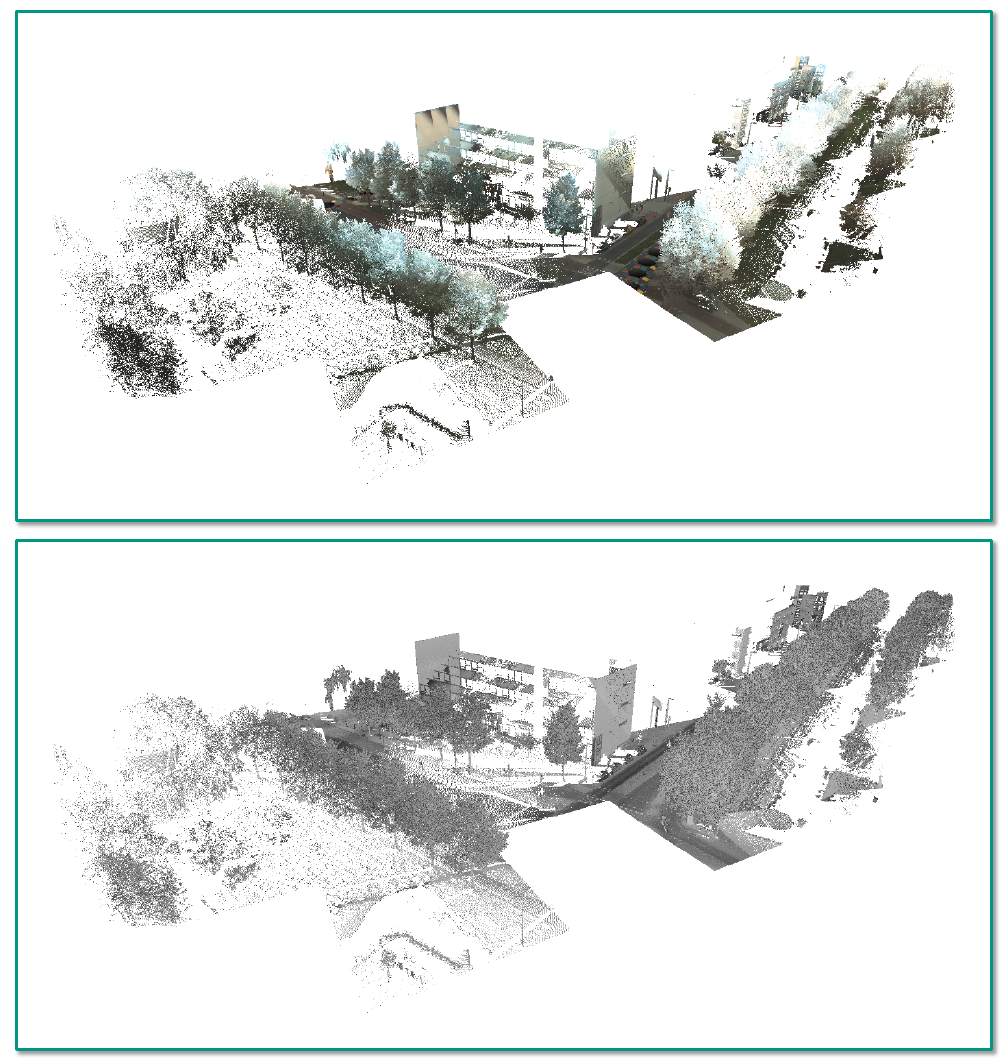
Figure 1. The MMS point cloud dataset released in the scope of the IQmulus Processing Contest IQPC’15: 3D point cloud colored with respect to the provided RGB values ( top ) and 3D point cloud colored with respect to the provided reflectance information ( bottom